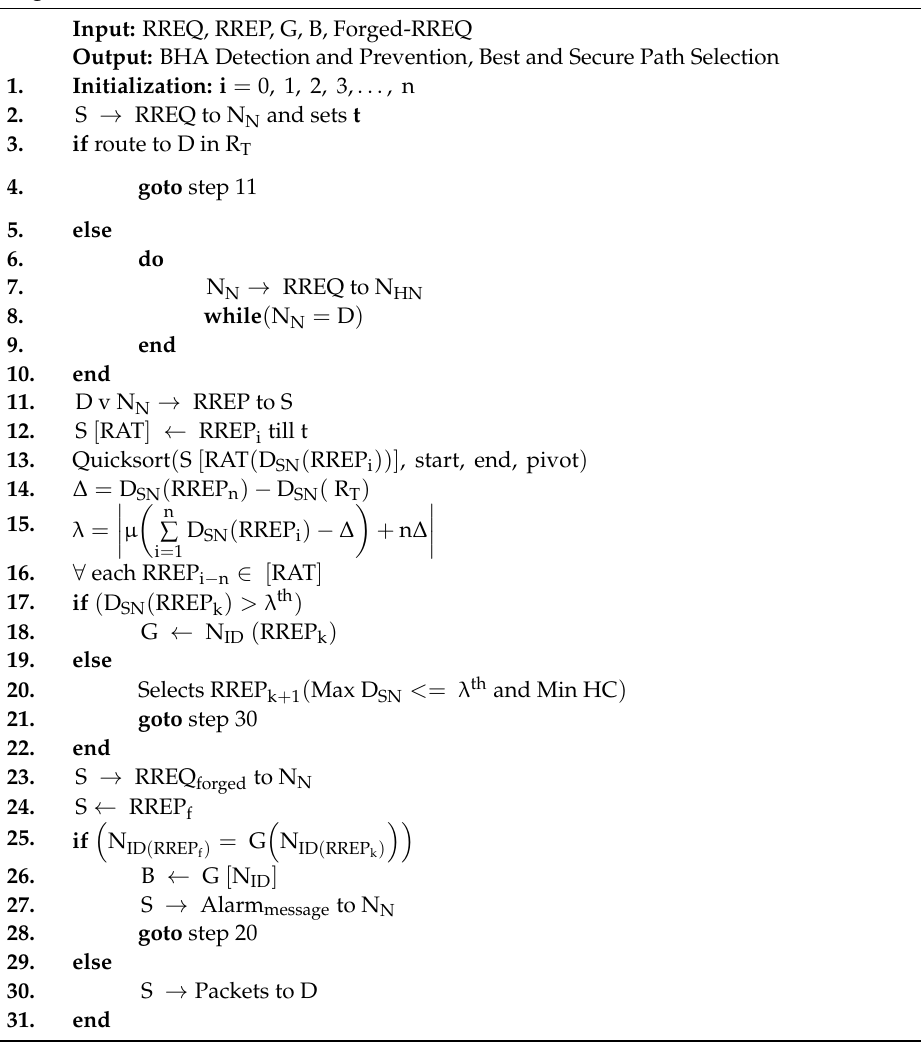
Algorithm 1: Black Hole Attack Detection and